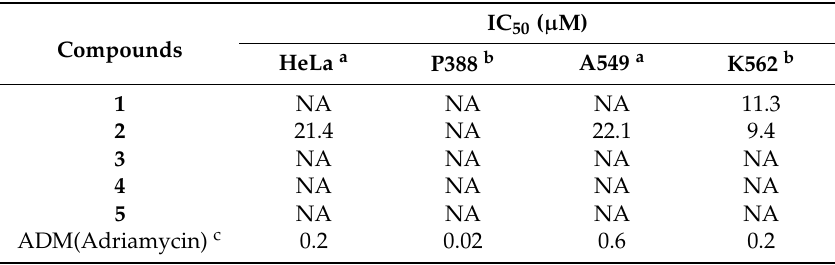
Table 3. The IC 50 values of the compounds 1 – 5 against four tumor cell lines.